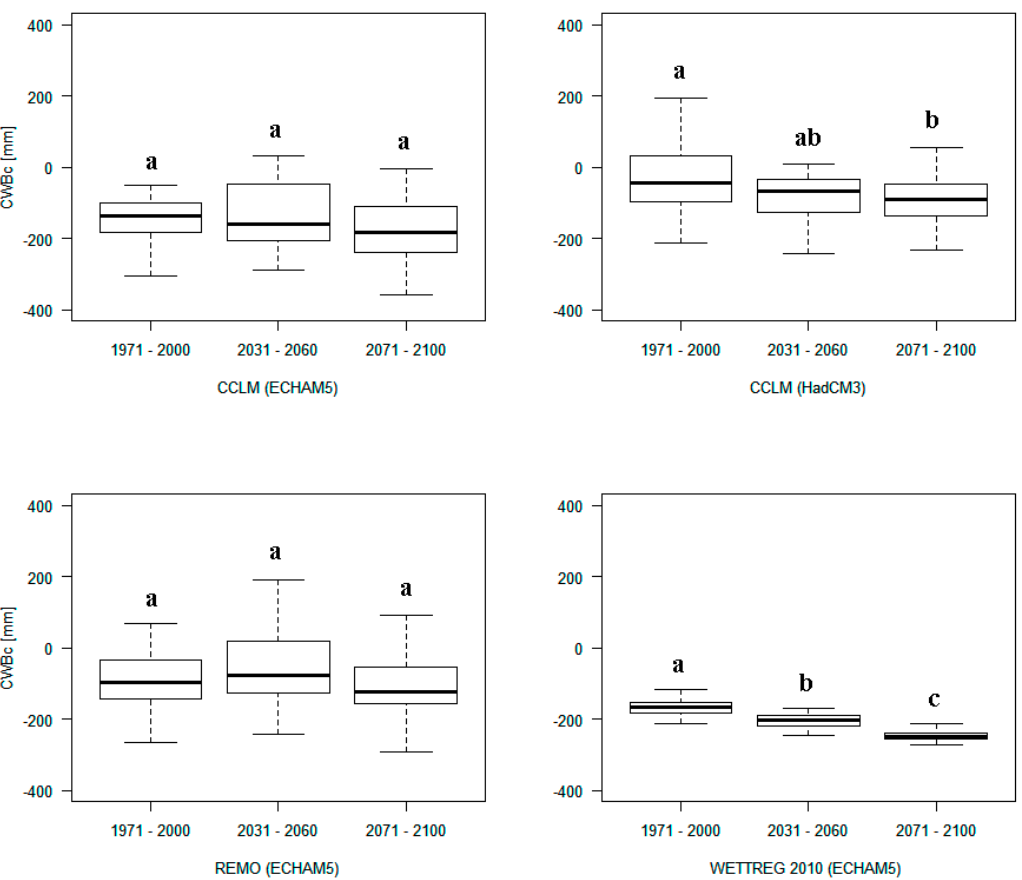
Figure 4. RCM simulated crop specific Climatic Water Balance ( CWB C in mm) of onions in model region “Hessian Reed” during growing season from March till October. Significant differences between the 30-year periods are labelled with different letters (ANOVA, Tukey, Kruskal-Wallis, post-hoc HSD Test, alpha = 5%).